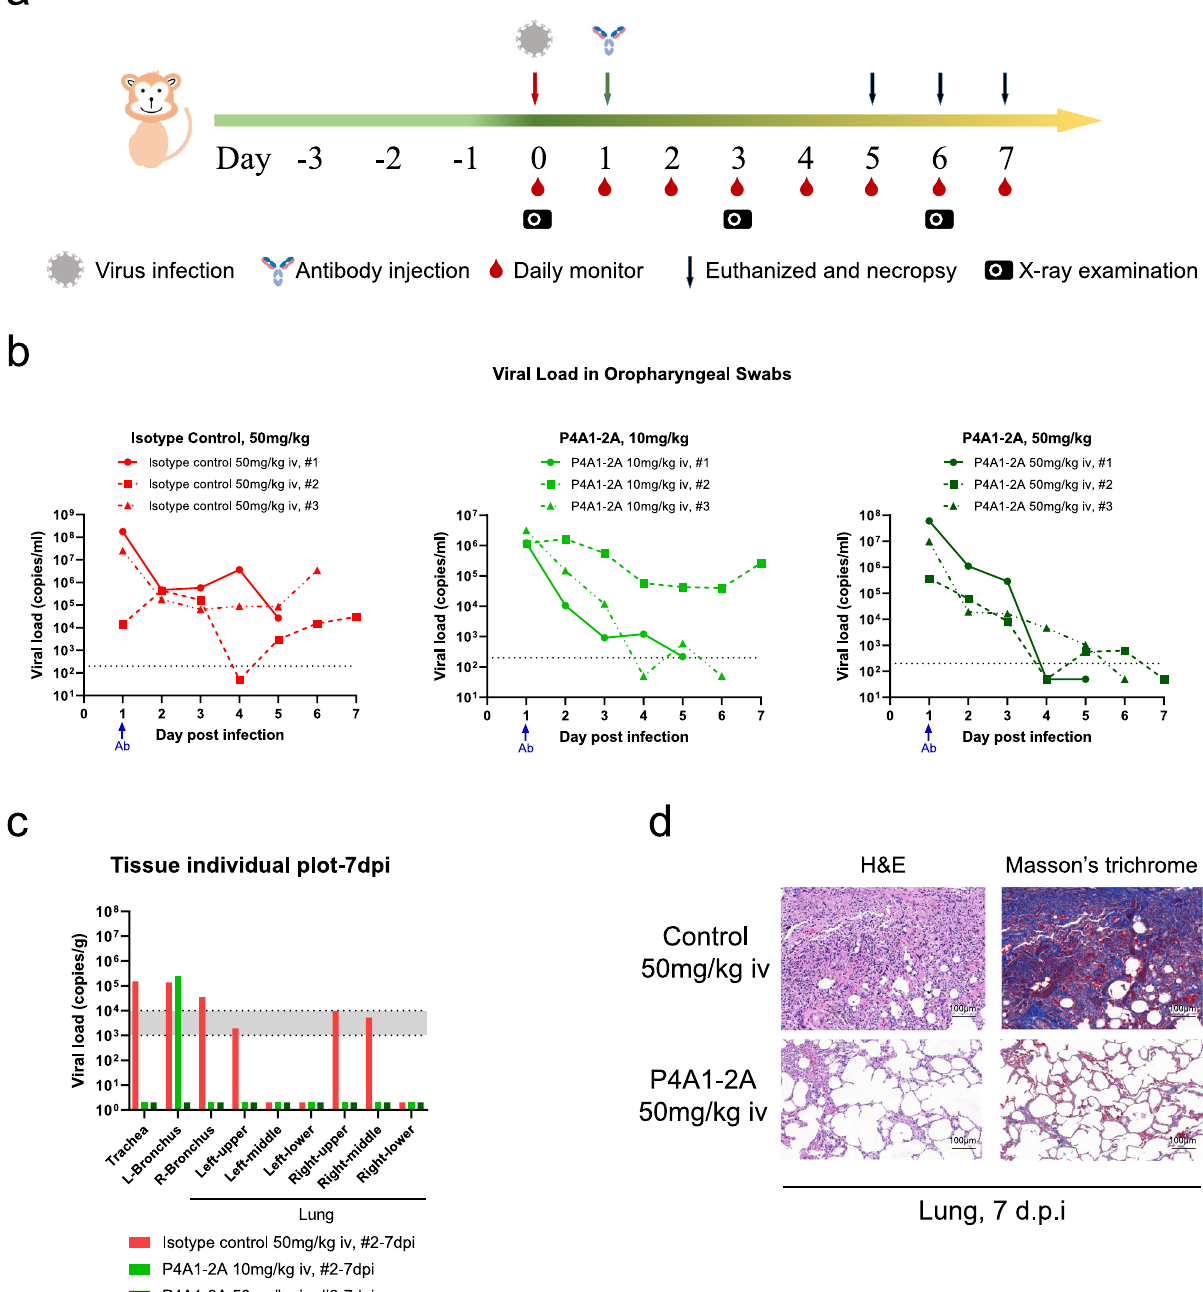
Fig. 4 Therapeutic ef fi cacy of in the rhesus macaque model of SARS-CoV-2 infection. a Experimental design for therapeutic testing of P4A1 – 2A in the rhesus macaque ( n = 3/group). b Viral load in oropharyngeal swabs tested by RT-qPCR was monitored for 7 days. c Viral load in the respiratory tissues (including trachea, left and right bronchus, and all six lung lobes) collected at necropsy on 7 days post infection (d.p.i., n = 1/group) was tested by RT-qPCR. d Representative images of histopathology in lung tissue from isotype control or P4A1 – 2A 50 mg/kg treated animals (collected at 7 d.p.i., n =